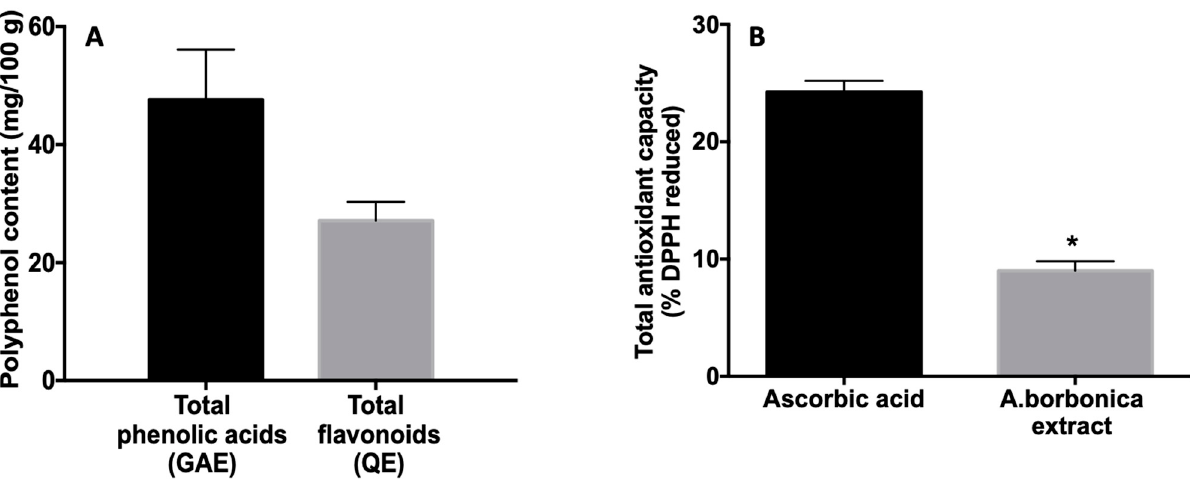
Figure 1. Total phenolic acid and flavonoid contents ( A ) and antioxidant capacity ( B ), from A. borbonica extract administered by gavage. ( A ) Total phenolic contents were determined by using the Folin–Ciocalteu colorimetric assay and total flavonoid contents were determined by using the aluminum chloride colorimetric assay. The results are expressed as mg gallic acid equivalent (GAE)/100 g and as mg quercetin equivalent (QE)/100 g plant dried powder. ( B ) Total antioxidant capacity was measured by DPPH assay. Positive control ascorbic acid was used at the same phenolic acid concentration (47 mg GAE) as that provided by the A. borbonica extract. The results are expressed as % of reduced DPPH. Data are means ± SD of three independent experiments. * p < 0.05 vs. ascorbic acid.